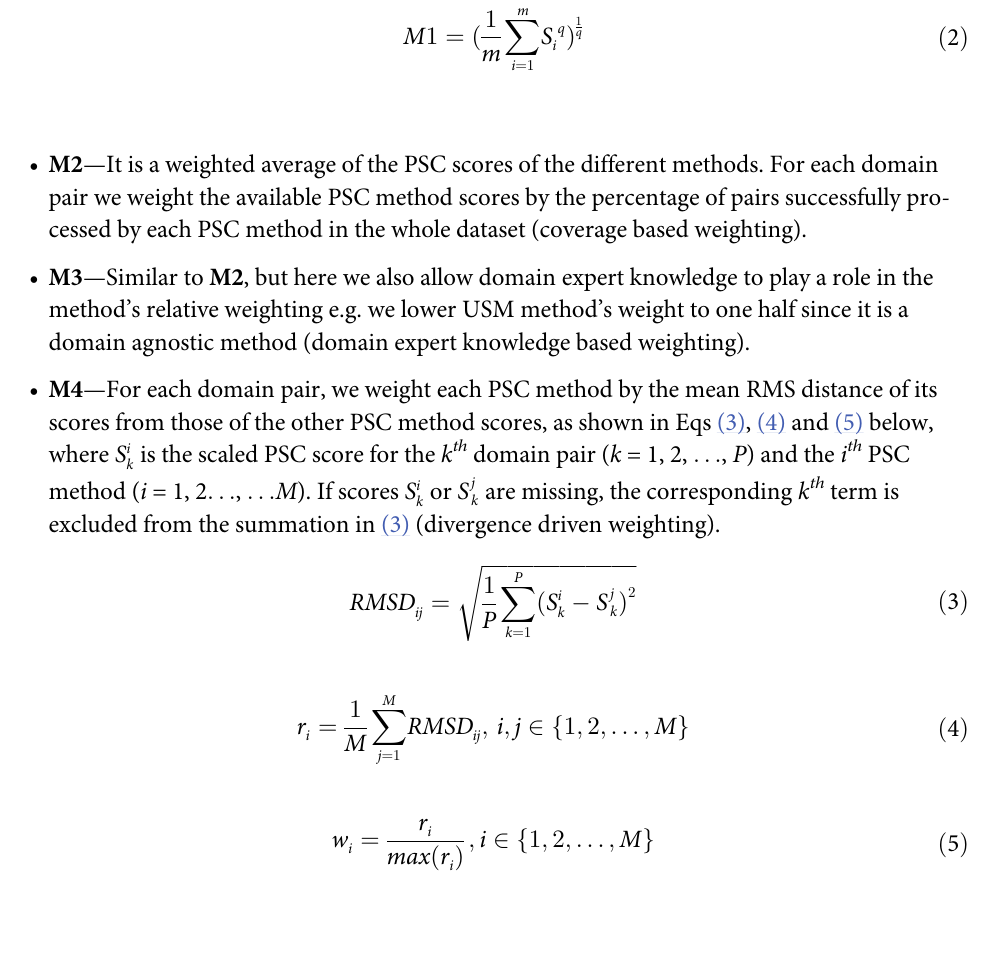
MCPSC consensus scores calculation. pyMCPSC produces five alternative MCPSC